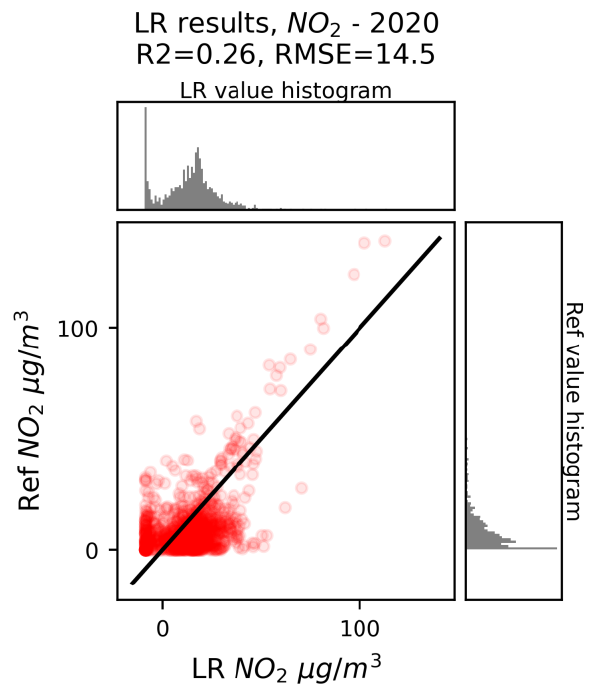
Figure 2. The results of the LR performed in the year 2020.